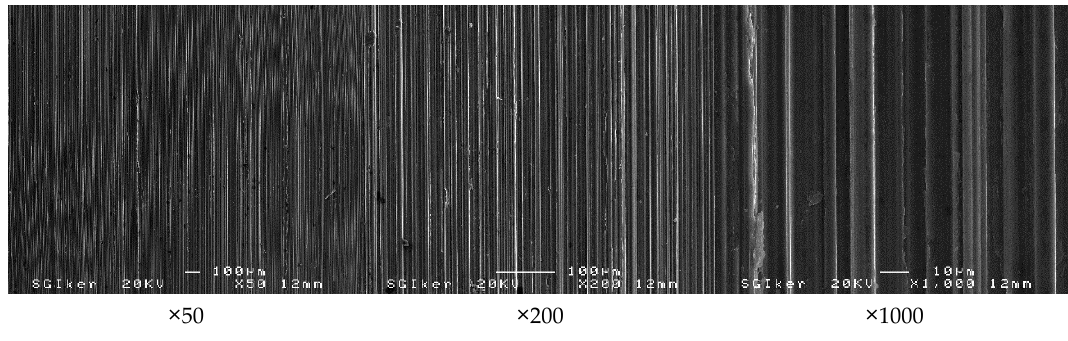
Figure 15. AA ‐ 5083 ‐ O disk.